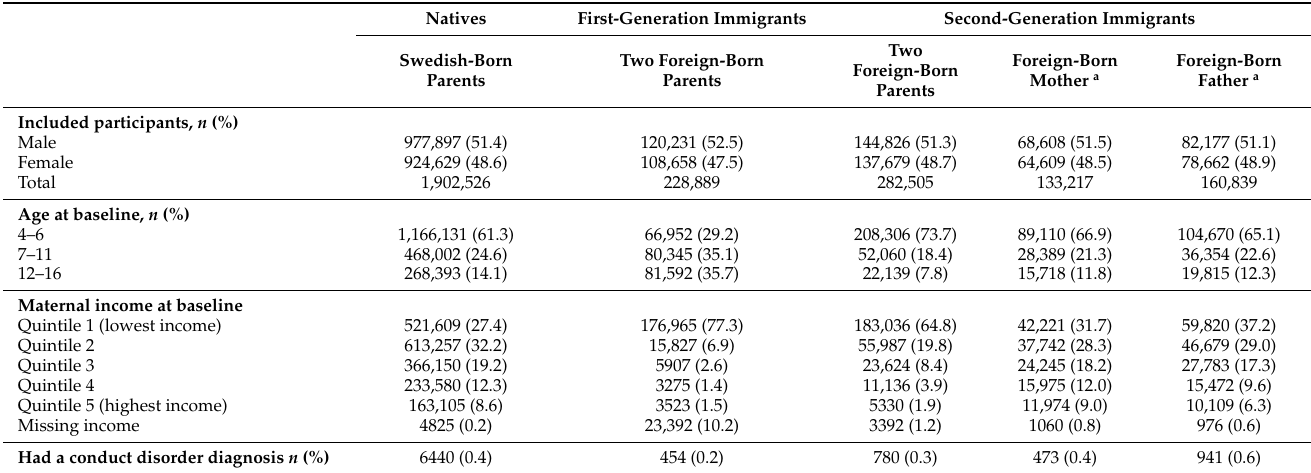
Table 1. Characteristics of participants with a native or immigrant background in Sweden, born 1987–2010. Natives First-Generation Immigrants Second-Generation Immigrants Two Swedish-Born Two Foreign-Born Foreign-Born Foreign-Born Mother a Foreign-Born Father Parents Parents